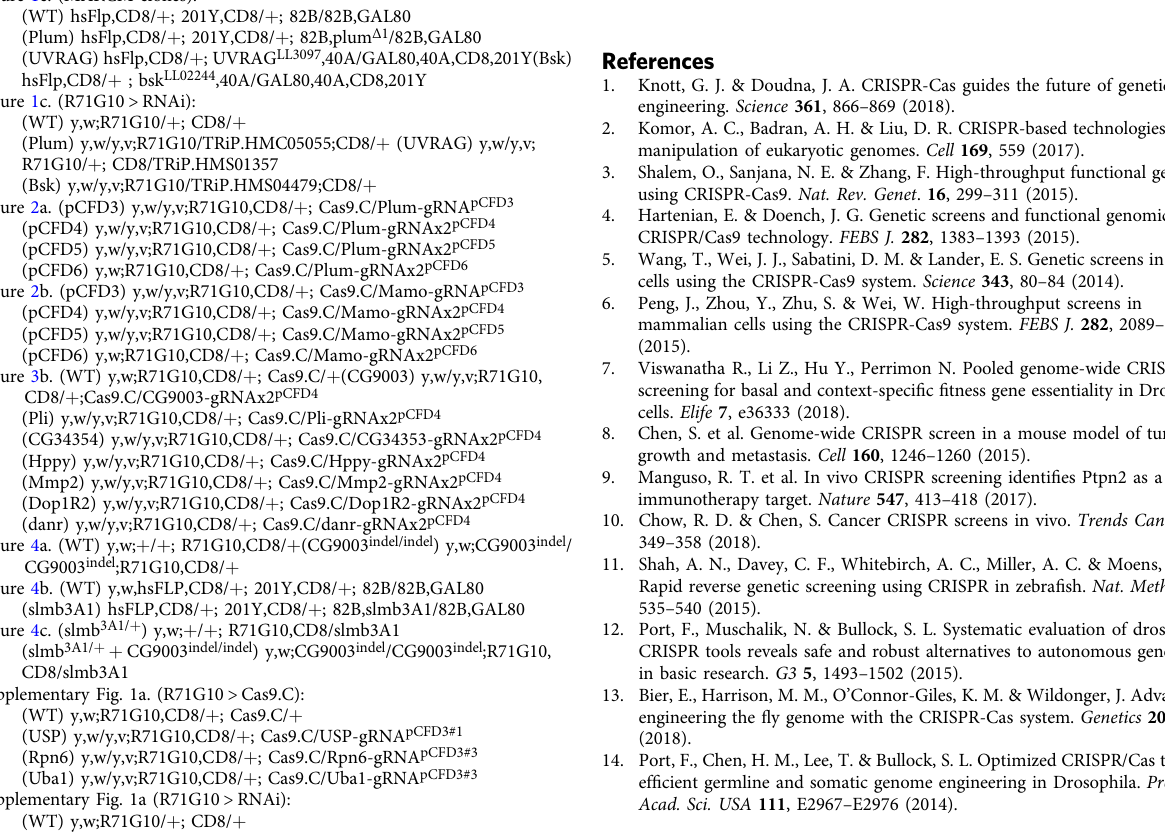
Figure 1c. (MARCM clones): (WT) hsFlp,CD8/ + ; 201Y,CD8/ + ; 82B/82B,GAL80